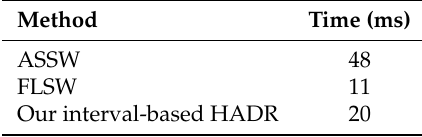
Table 5. Comparison of time